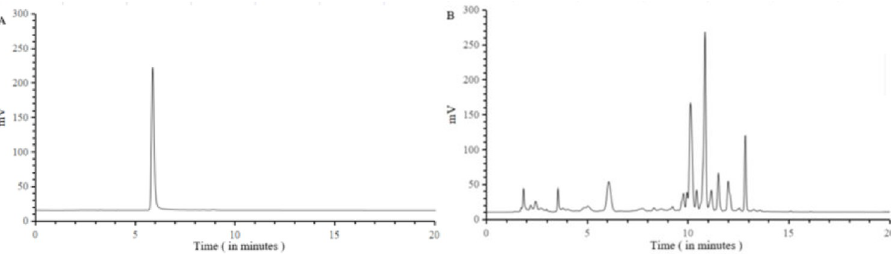
Fig 1. Results of high-performance liquid chromatogram of the chlorogenic acid. (A) HPLC of the chlorogenic acid standard, and (B) HPLC of the chlorogenic acid in dandelion sample.